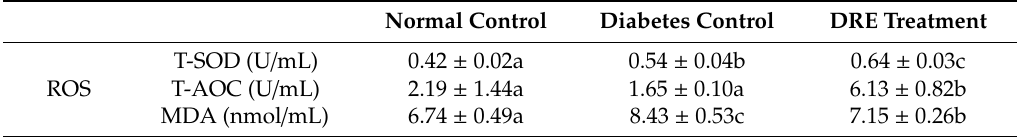
Table 2. Reactive oxygen species (ROS) in the experimental